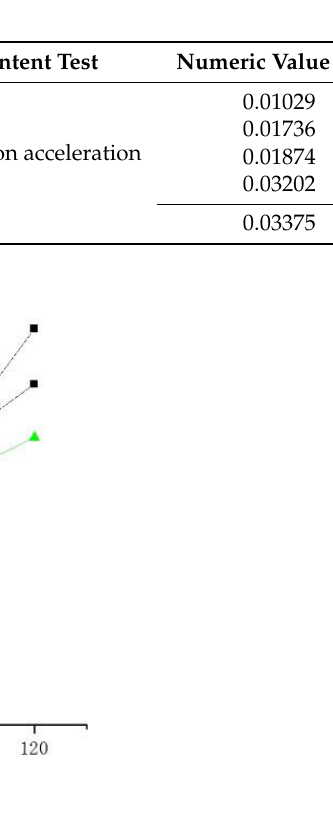
( b ) Figure 10. Testing vibration acceleration curve. ( a ) is Speed 60 km/h; ( b ) is Speed 120 km/h.